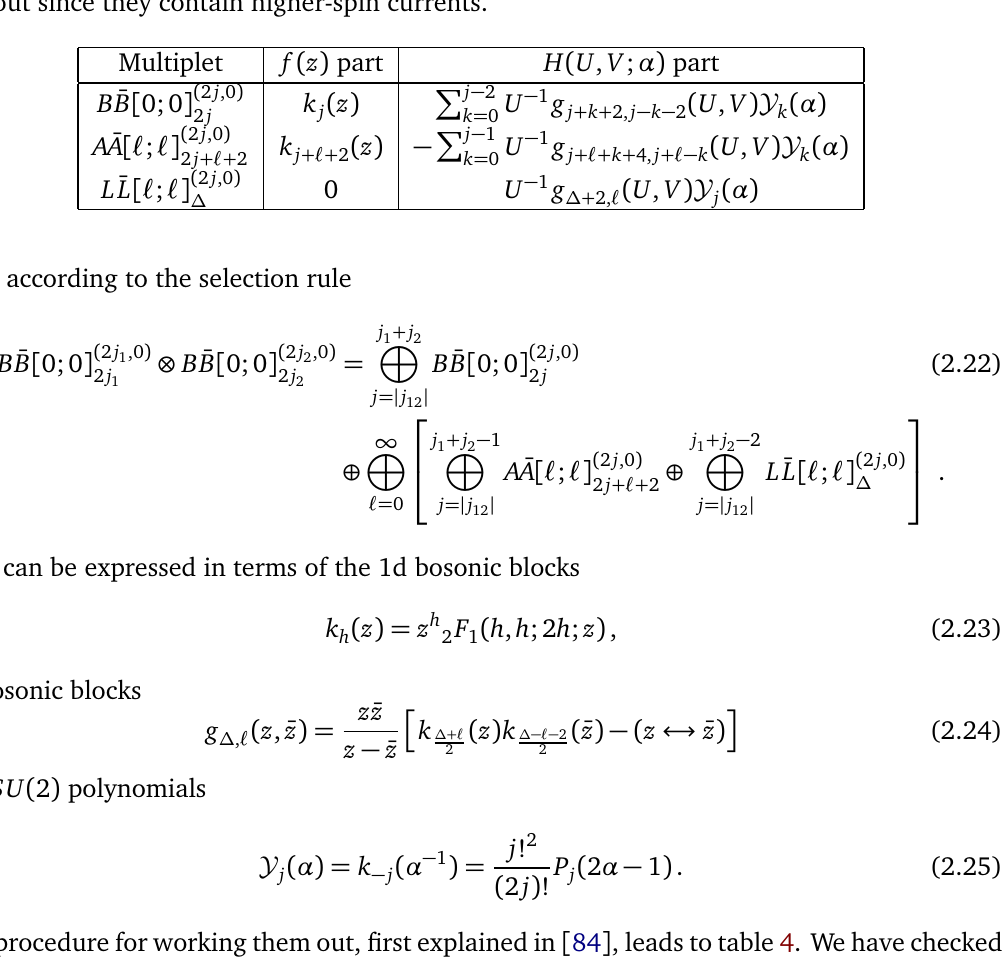
Table 4: Expressions for the superconformal blocks in a form which shows that they manifestly satisfy the superconformal Ward identity. One can see that the j = 0,1 elements of the first row (identity and moment map) only contribute to the chiral correlator. The j = 0 multiplets in the second row would as well but these are ruled out since they contain higher-spin